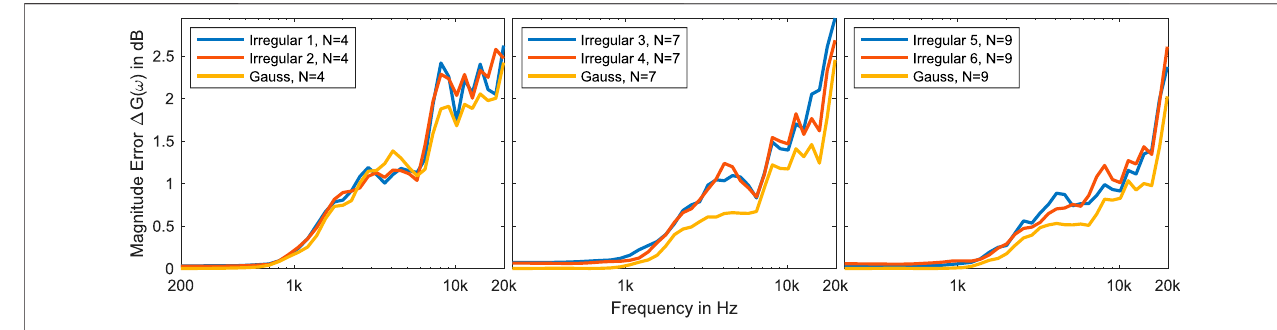
FIGURE 7 | Left-ear magnitude error Δ G ( ω ) for six examined irregular grids and three regular Gauss grids, with estimated optimal (irregular) or corresponding (regular) SH order. HRTF: Subject no. 10 from HUTUBS database.